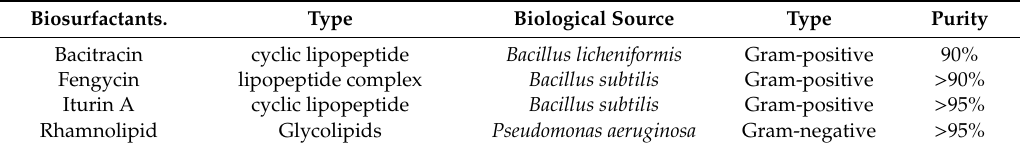
Table 1. List of biosurfactants, their types, and their biological